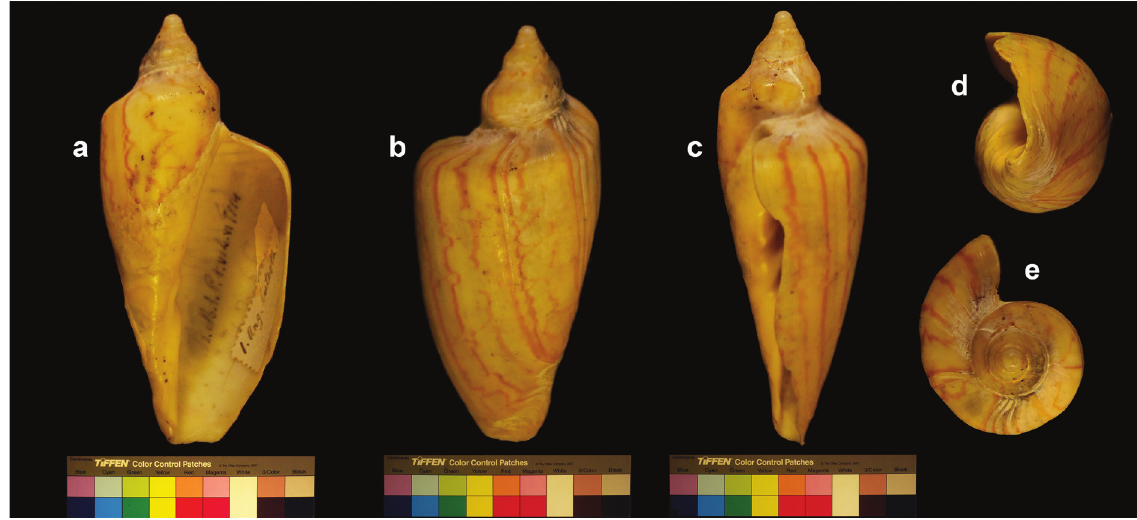
Figure 20. Voluta angulata luteola , specimen figured by Lahille (1895: pl. VI, fig. 114). a Apertural view b Dorsal view c Lateral view d Umbilical view e Apical view. Scale bar: 5 cm.